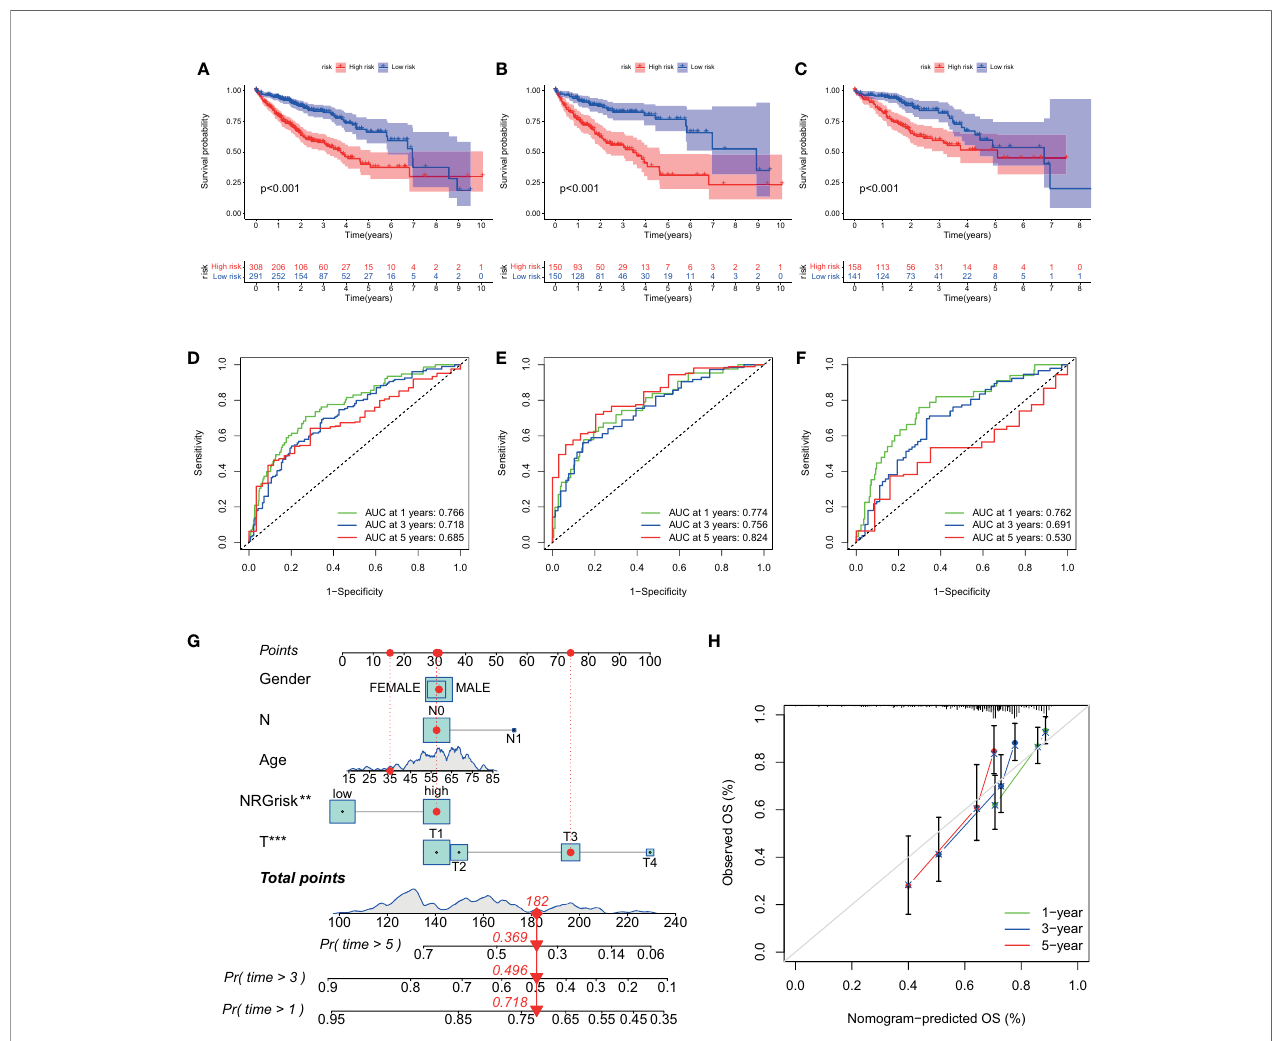
FIGURE 5 | Evaluation of predictive power of NRGscore in training and test cohorts. (A, C) Kaplan-Meier curves showed that the high NRGrisk group had a more inferior OS than the low NRGrisk group in TCGA and ICGC cohorts, of which 599 cases were in the overall set (A) , 300 cases were in training set (B) , and 299 cases were in the test set (C) . (D-F) ROC of NRGscore scheme: Areas under the curve of 1-, 3-, and 5-year OS in the overall set (D) , training set (E) , and test set (F) . (G) Nomogram predicting 1-, 3-, and 5- year OS of patients based on NRGscore and other clinical parameters, including gender, age, T stage, and N stage. The red dot presented the point of each parameter, and the length of the line segment re fl ected the contribution of factors to the outcome event. (H) Calibration plot of the nomogram for predicting the probability of 1-, 3-, and 5-year OS. The colored line was the fi t line and represented the predicted value (the horizontal axis) corresponding to the actual value (the vertical axis). The gray diagonal was the ideal case. P<0.01**; P<0.001***. TCGA, the cancer genome atlas; ICGC, international cancer genome consortium; NRGscore, necroptosis-related gene score; NRGrisk, necroptosis-related gene risk; ROC, receiver operating characteristic curves; OS, overall